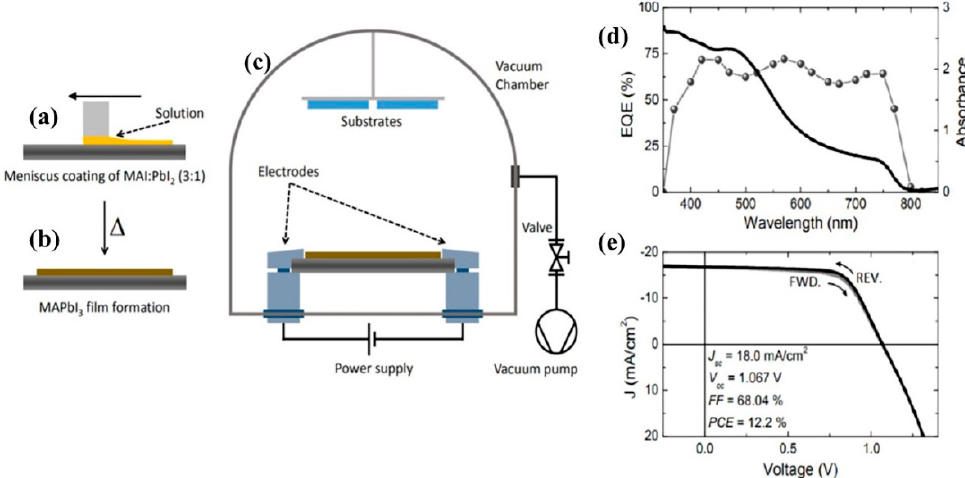
Figure 15. ( a ) Schematic of the deposition of hybrid organic–inorganic perovskite thin films via flash evaporation. The precursor solution is smeared onto a tantalum foil. ( b ) Annealed process to obtain a polycrystalline film. ( c ) The coated tantalum sheet, in a vacuum chamber, evaporates to the desired substrate. ( d ) EQE and optical absorption in the UV–visible region, deposited by flash evaporation. ( e ) J – V curve in forward and reverse bias for a device under illumination with the structure ITO/PE-